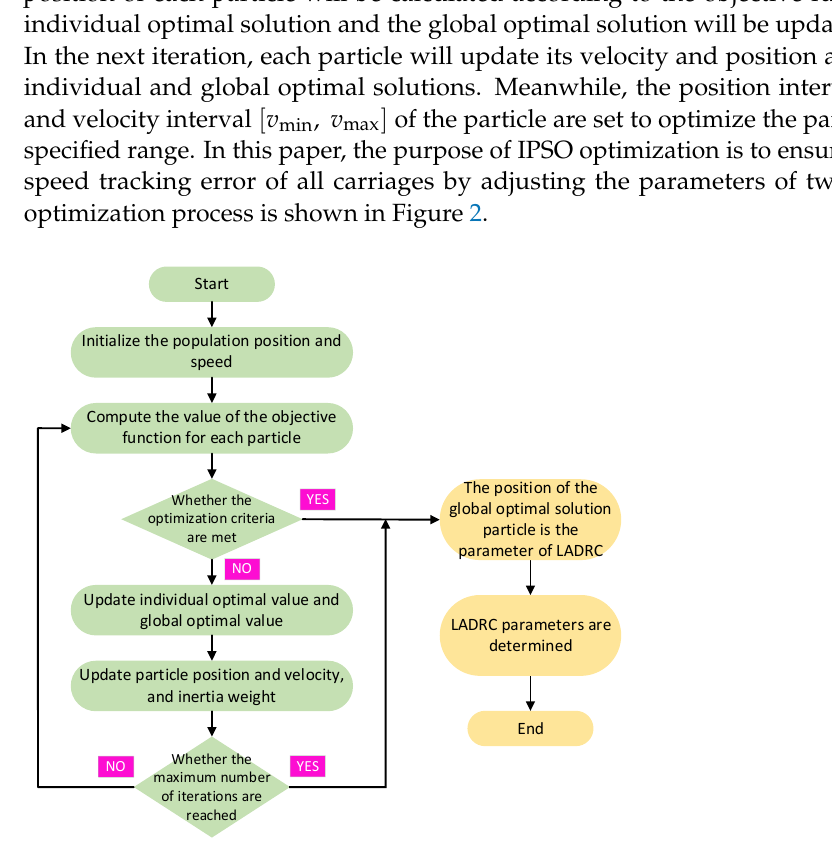
Figure 2. IPSO algorithm optimization process.